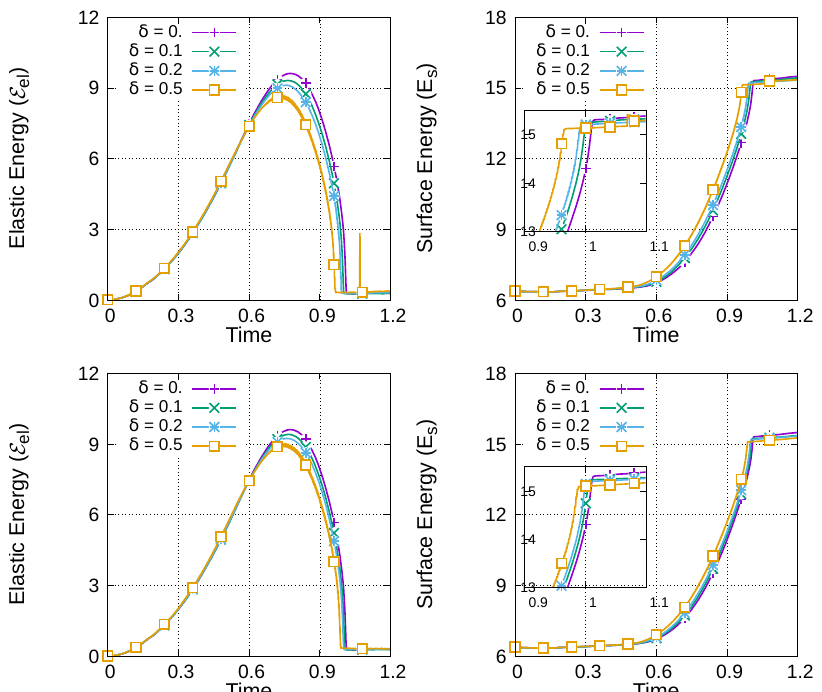
Figure 13. Profile of the elastic ( left ) and surface energy ( right ) under thermal expansion during crack propagation using TF-PFM1 ( top ) and TF-PFM2 ( bottom